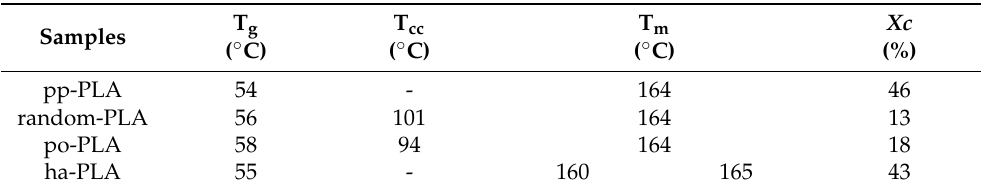
Table 3. Temperatures of glass transition (T g ), cold crystallization (T cc ), melting (T m ) and crystallinity percentage Xc of samples. Errors in T ± 1 ◦ C.